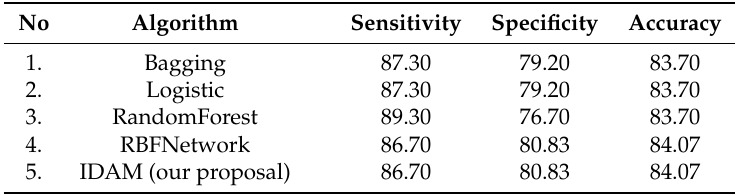
Table 3. Classification accuracy of the five best-performing algorithms using Heart Disease Dataset. No Algorithm Sensitivity